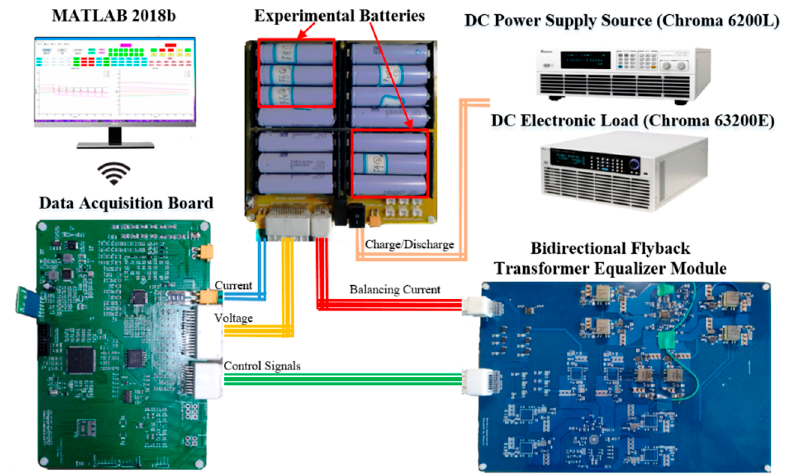
Figure 7. Schematic of experimental bench. Table 4. Specifications of the tested battery.